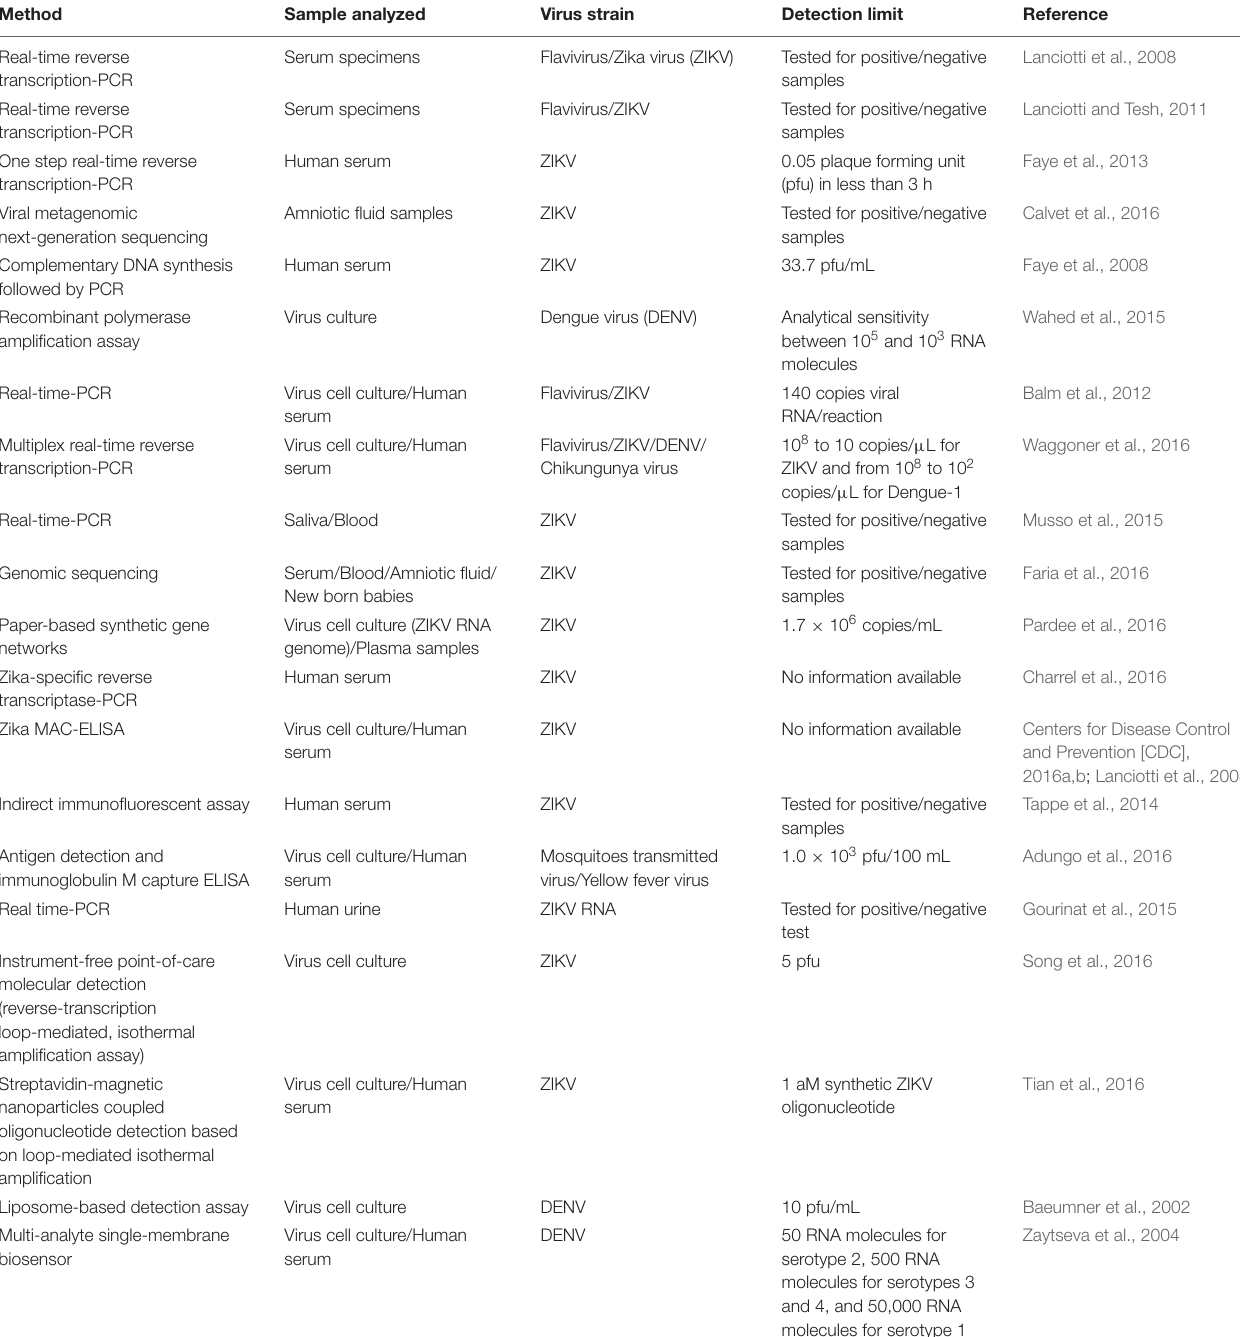
TABLE 1 | Methods available and applied for Zika virus